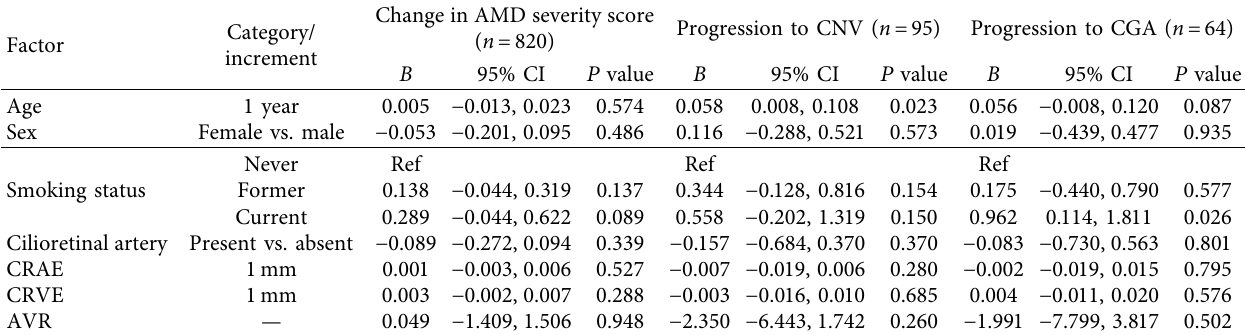
Table 4: Retinal vascular parameters associated with AMD progression after 5